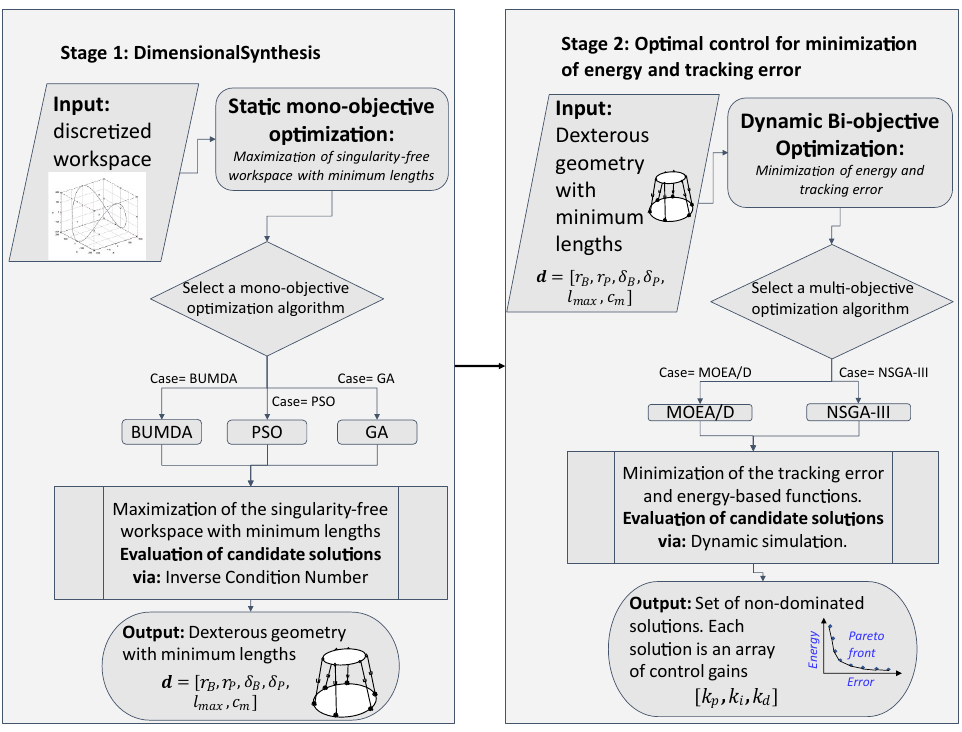
Figure 5. Flowchart of the general optimization process. Stage 1, on the left, finds the geometrical configuration, and Stage 2, on the right, finds the optimal control parameters. Notice that both stages are